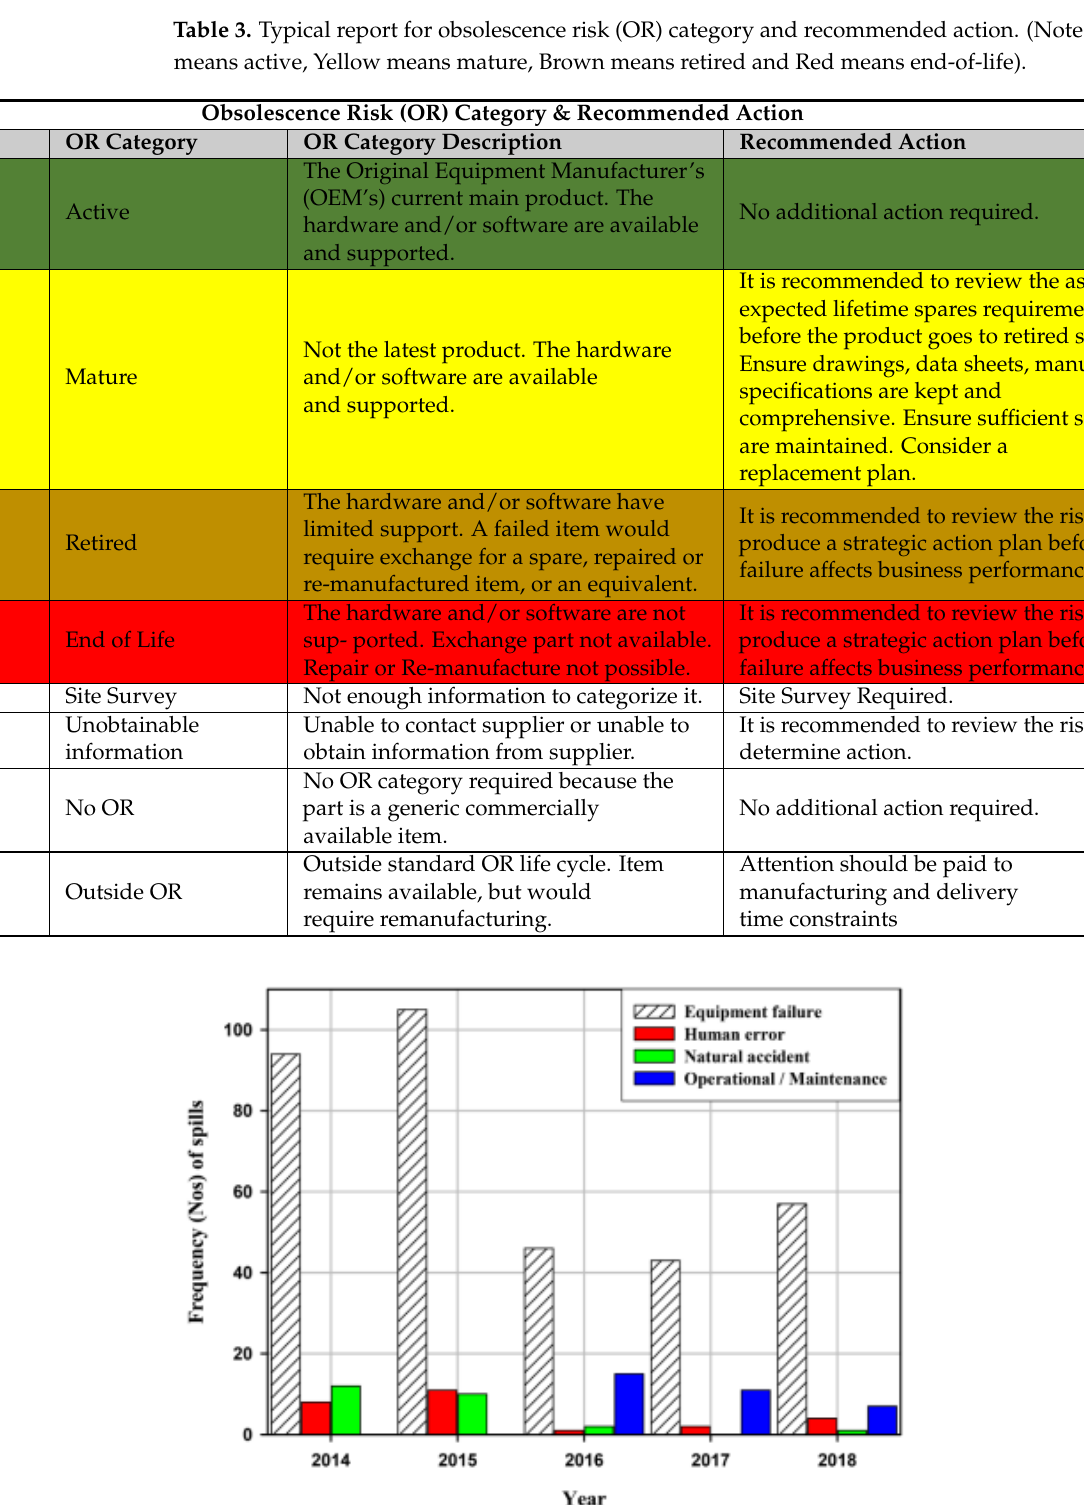
Figure 22. Different factors that were considered for failures of offshore pipelines due to vandalism, corrosion and yet-to-be-determined (YTBD) factors. (Image was reused with permission of authors